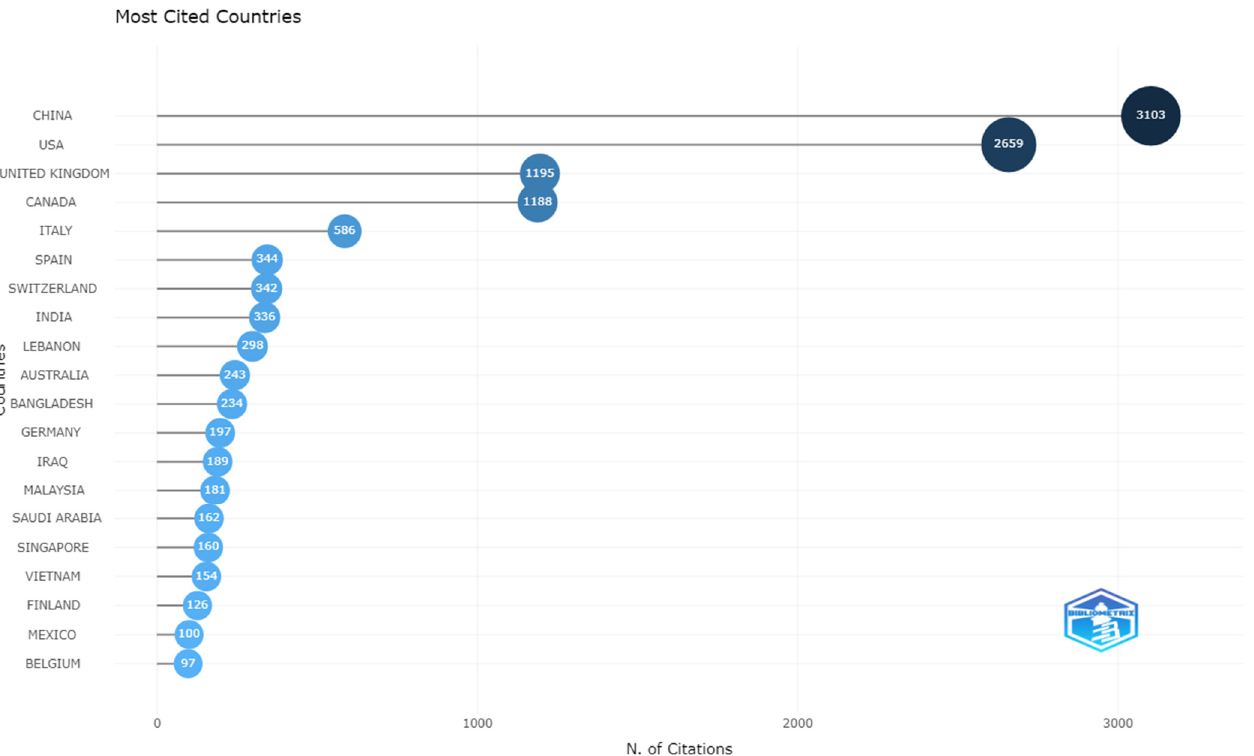
Figure 2. Most cited countries (this chart was generated by Biblioshiny).